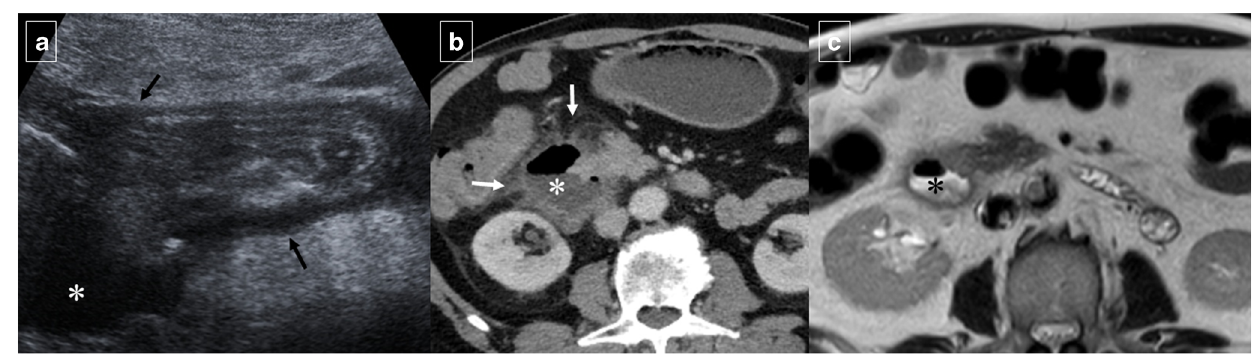
tissue stranding (arrows) caused by acute duodenal diverticulitis. c Axial T2-weightedMRIafter conservativetherapyshowsthe outpouching from the duodenal wall is smaller and more well-defined; it now has the appearance of a duodenal diverticulum, and the amount of soft-tissue stranding has